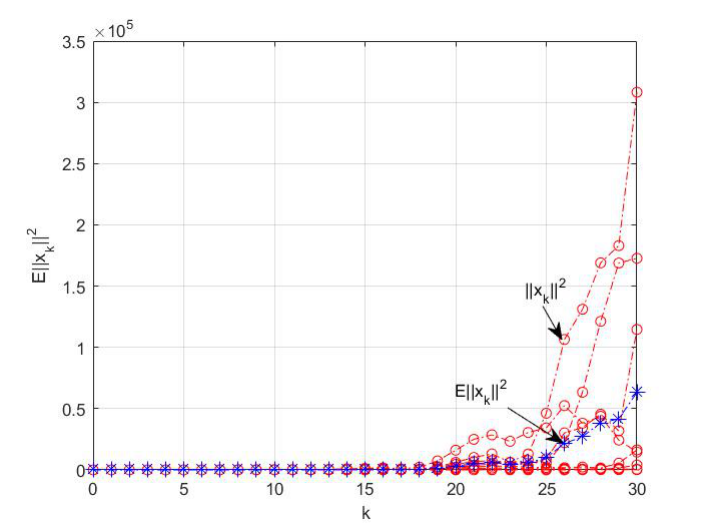
Figure 2. The norm E (cid:107) x k (cid:107) 2 curve of the system state with respect to the iteration step k in Example